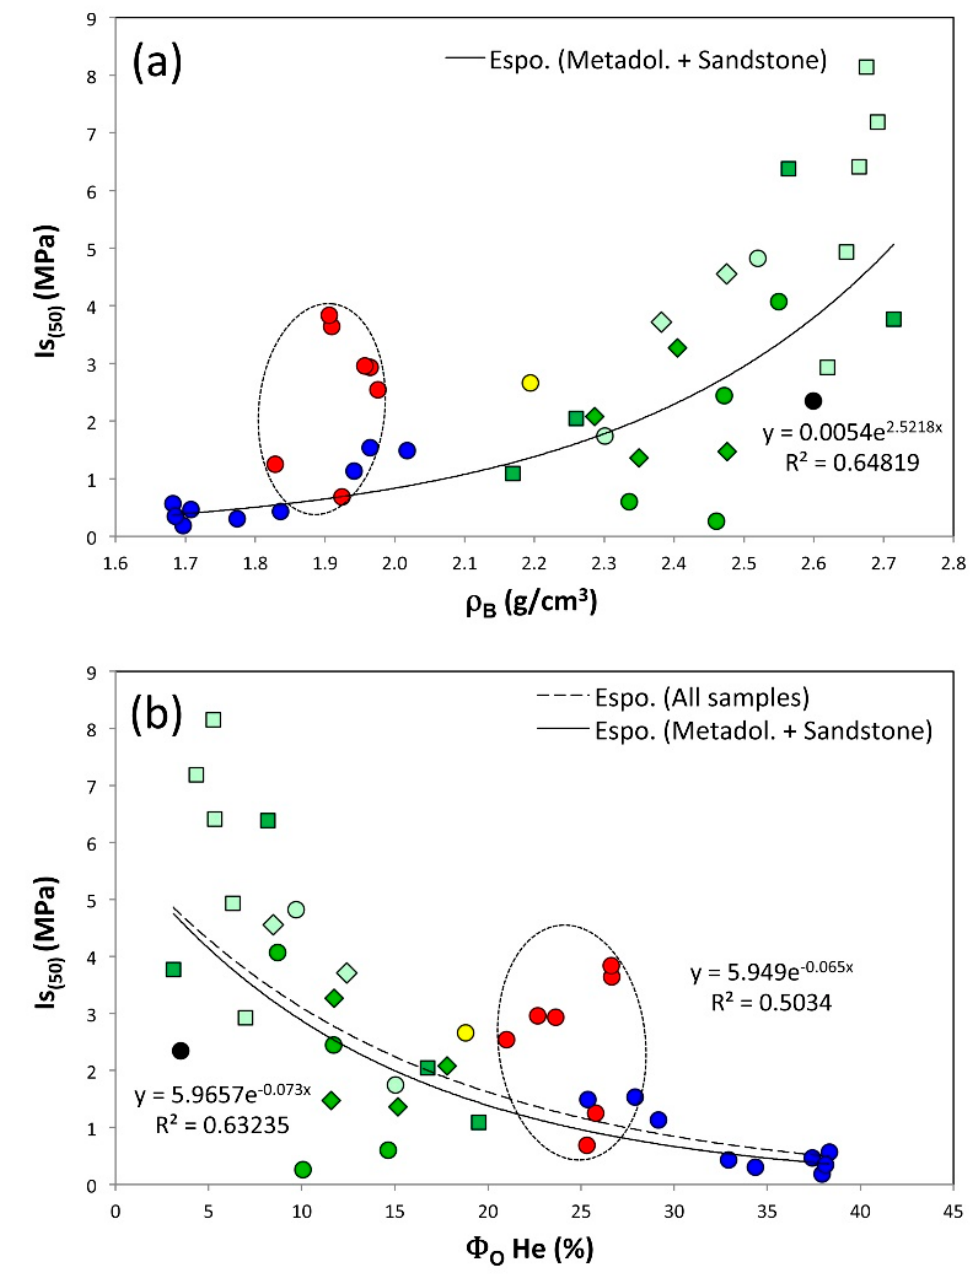
Figure 13. ( a ) Bulk density (( ρ B ) vs. PLT index (Is (50) ); ( b ) helium open porosity ( Φ He) vs. PLT index (Is (50) ). Observing the data as a whole, the bulk density showed a clear linear negative correlation with porosity (Figure 11a) and no evident positive correlation with the real density (Figure 11b) due to the presence of populations of the sandstone and especially “sandstone” s.l. samples, which had different physical properties with respect to the metadolostone, showing a clear linear positive correlation coefficient (R 2 = 0.6, Figure 11b). The bulk density had average values ranging from a minimum of 2.40 ± 0.07 g/cm 3 in the samples of brecciated dolomite, an intermediate value of 2.44 ± 0.10 g/cm 3 in the samples of massive dolomite, to a maximum of 2.56 ± 0.20 g/cm 3 in the laminated dolomite samples (Table 2). The sandstone showed a much lower value of 1.81 ± 0.13 g/cm 3 , as well as the “sandstone” s.l. samples, in which there was an average value of 1.92 ± 0.05 g/cm